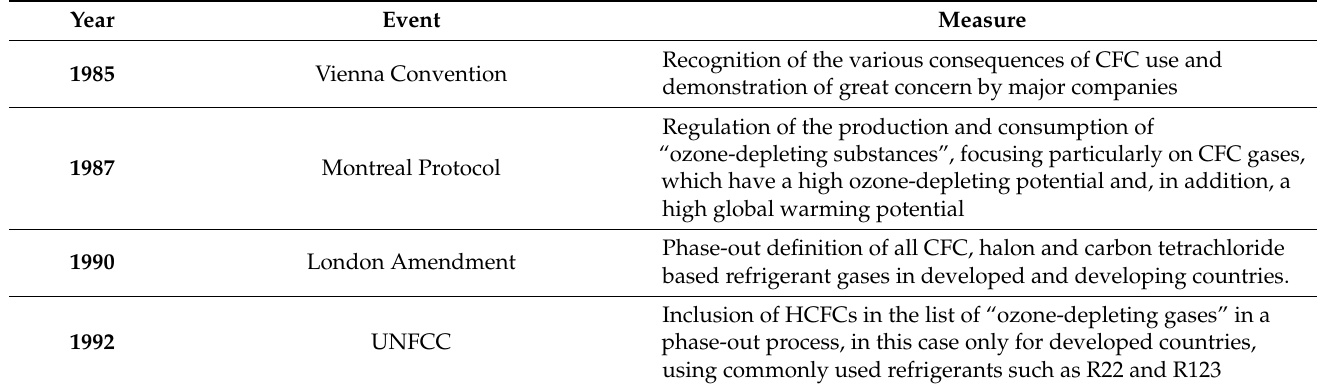
Table 1. Historical evolution of refrigerants taking into account their environmental